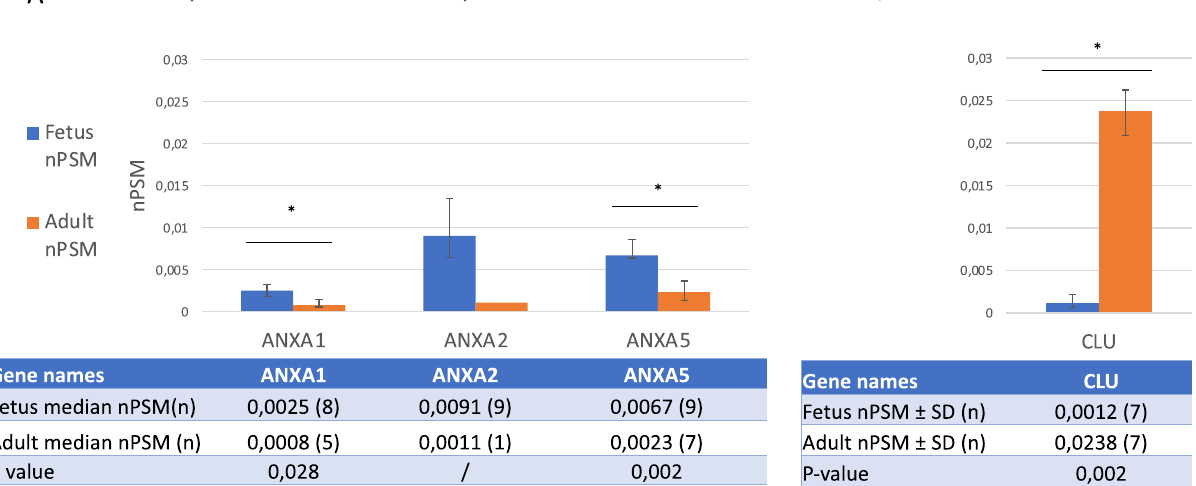
Figure 3. Comparing matrisome associated protein expression. Figure displays the comparisons of expressed proteins between fetus and healthy adults. ( A ) Shows the expression of matrisome affiliated and ( B ) secreted factors. The Y-axis displays median normalized PSM’s per group, X-axis shows protein gene symbols, error bars are Interquartile ranges and * indicates statistical significance. The attached table contains the median (number of samples) for each group and provides the according Mann Whitney U p values if statistics could be performed (n ≥ 4). ‘/’ indicates that 3 or less samples were present in one of the groups and no statistical test could be performed.